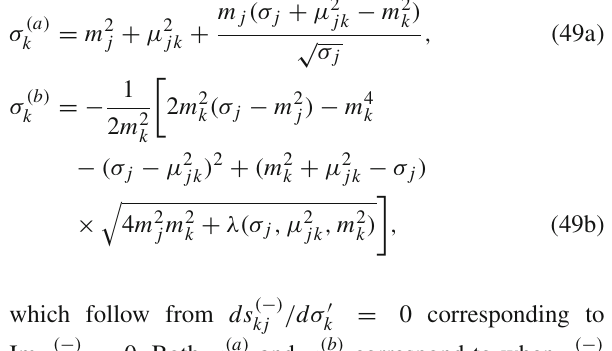
( + ) branch point always lies in kj